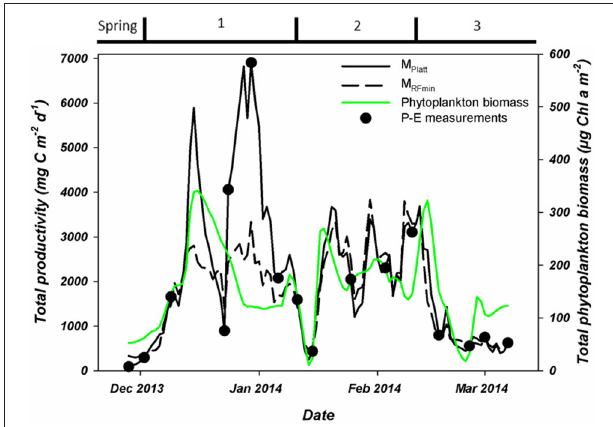
FIGURE 7 | Total, water column integrated primary production as measured during P-E experiments (black dots) or estimated using two modeling approaches. These estimates are based on Platt et al. (1980; solid black line) or the minimal random forest model constructed in this study (dashed black line). Also shown is the water column integrated phytoplankton biomass. All integrations were to a depth of 80 meters. Period 1 starts on December 6th, period 2 on January 15th and period 3 on February